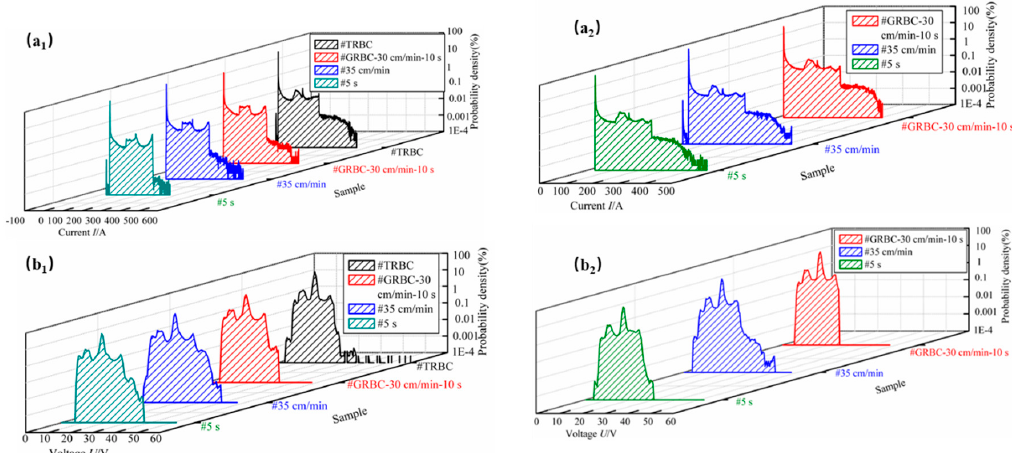
Figure 4. Comparison of probability density distributions of different layers and different samples: ( a ) Current probability densities ( a 1 ) on the 3rd layer of samples #TRBC, #GRBC-30 cm/min-10 s, #35 cm/min, and #5 s, and ( a 2 ) on the 10th layer of samples #GRBC-30 cm/min-10 s, #35 cm/min, and #5 s; ( b ) voltage probability densities ( b 1 ) on the 3rd layer of samples #TRBC, #GRBC-30 cm/min-10 s, #35 cm/min, and #5 s and ( b 2 ) on the 10th layer of samples #GRBC-30 cm/min-10 s, #35 cm/min, and #5 s. (TRBC and GRBC represent transient and gradual reduction of bottom current,